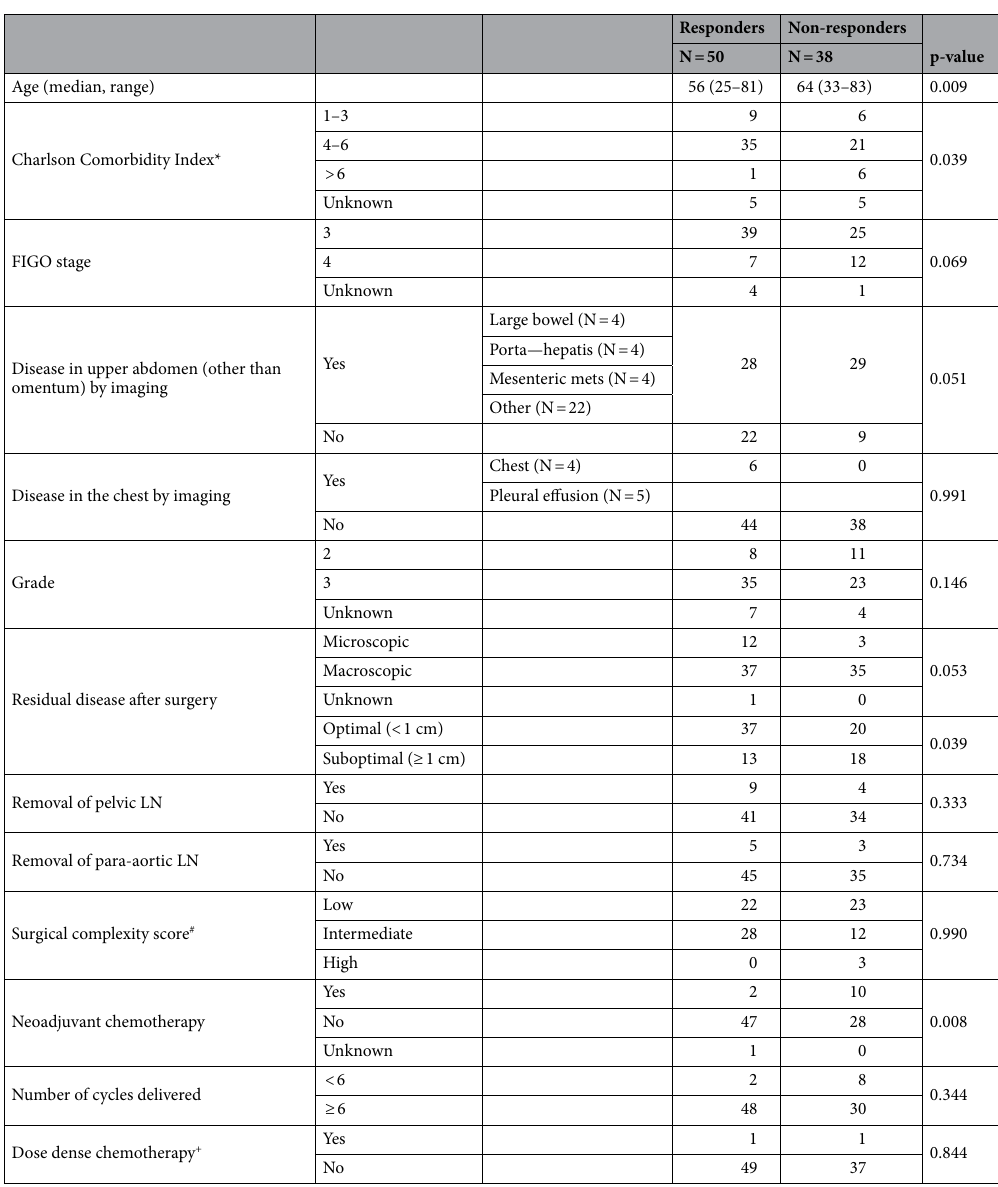
Table 1. Patient characteristics and association with treatment response. *Charlson Comorbidity Index is a measure of the prognostic burden of all associated morbidities to predict mortality, and is the most validated measure of the prognostic impact of multiple chronic illnesses (www.charl sonco morbi dity.com). # Surgical complexity score: score to predict surgical morbidity and 90-day mortality after primary debulking surgery for HGSC 67 . + Dose dense chemotherapy: increases the dose intensity of the regimen. In serous ovarian cancer, dose dense therapy consists in increasing IV administration of paclitaxel from every 3 weeks to